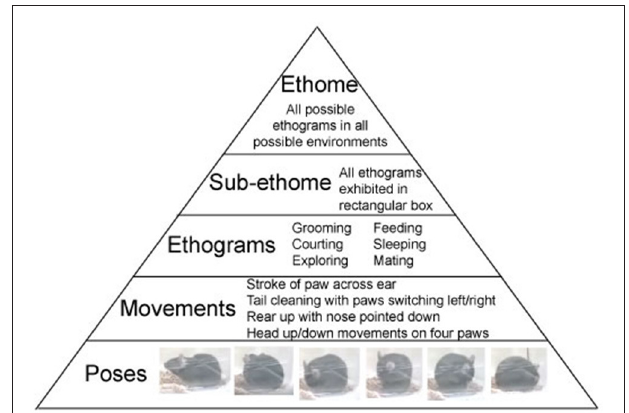
FIGURE 1 | Structure of Behavior. Ethome of an animal consists of numerous sub-ethomes (a complete set of ethograms in a specified environment), which consist of ethograms (sets of repeatable, predefined, trainable, or innate movements), which consist of movements (the smallest complete motion). Movements are built from poses (postural snapshots in time). Examples of mouse behavior are presented in the pyramid.